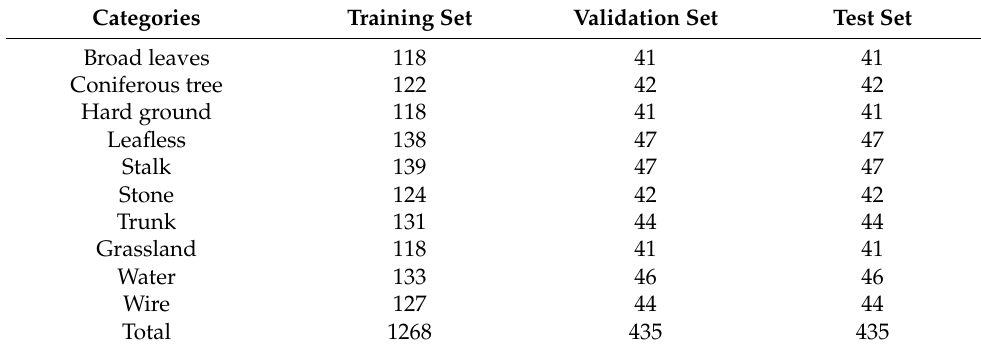
Table 1. Partitions of the 10 categories in the HEOBS-10